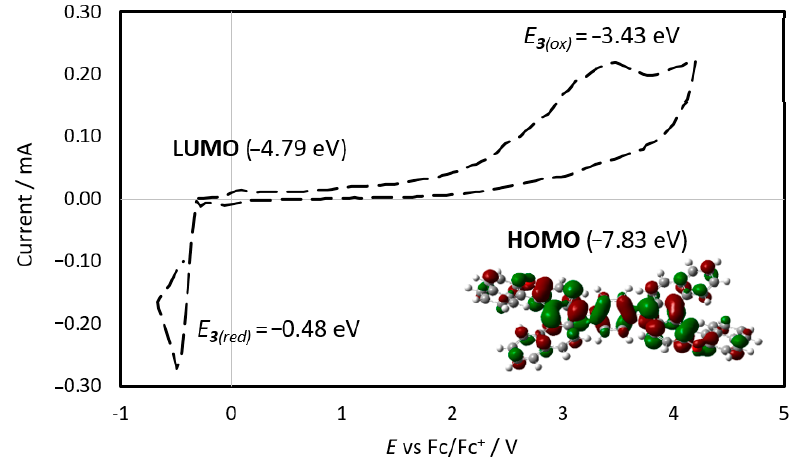
Figure 5. The cyclic voltammetry profile of 3 in (MeCN) with n -Bu 4 NPF 6 (0.1 M) using ferrocene as internal reference.